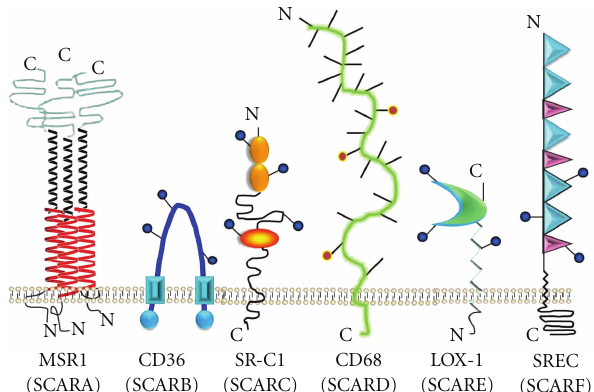
Figure 1: Structural diversity of the scavenger receptors. SCARA have a collagen-like domain believed to be their ligand-binding domain. CD68 has a mucin-like domain; LOX-1(oxidized-low density lipoprotein (lectin-like) receptor-1) (SCARE) has a C-type lectin domain and binds oxidized LDL. SCARF (scavenger receptor class F) has multiple extracellular EGF-like